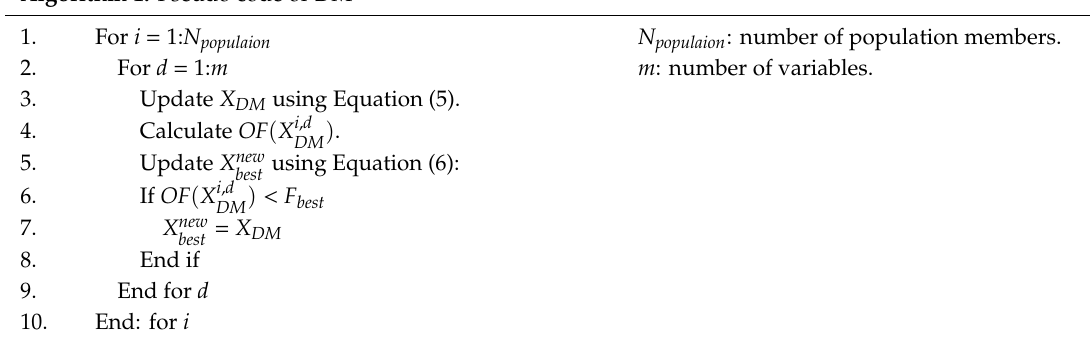
Algorithm 1. Pseudo code of DM